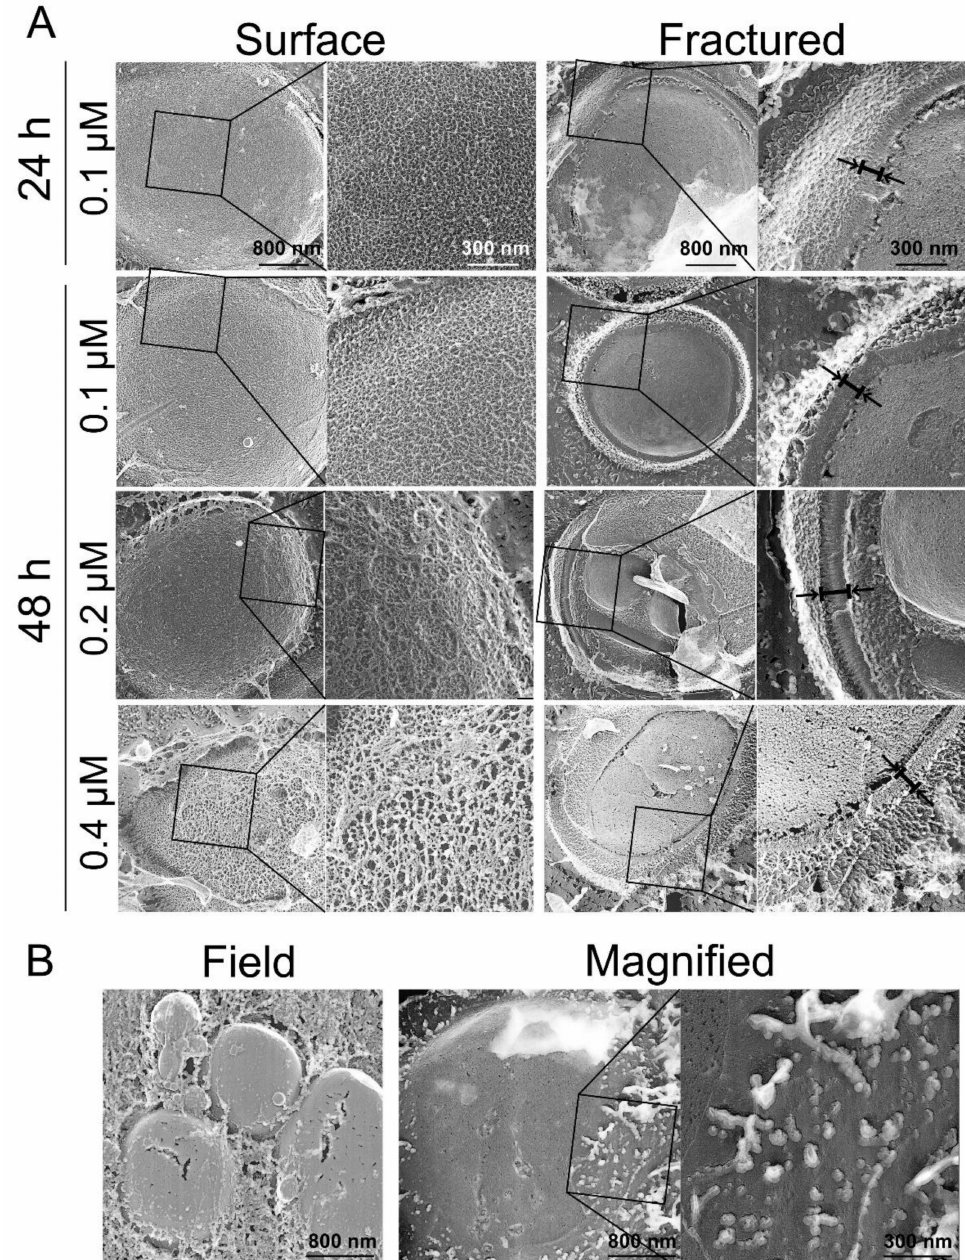
Figure 7. The surface and fractured images of micafungin- or zymolyase-treated yeast cells. ( A ) Expo- nentially growing cells were cultured in 2.5% ME treated with micafungin at 30 ◦ C. ( B ) Exponentially growing cells were treated with zymolyase 20T at 30 ◦ C for 30